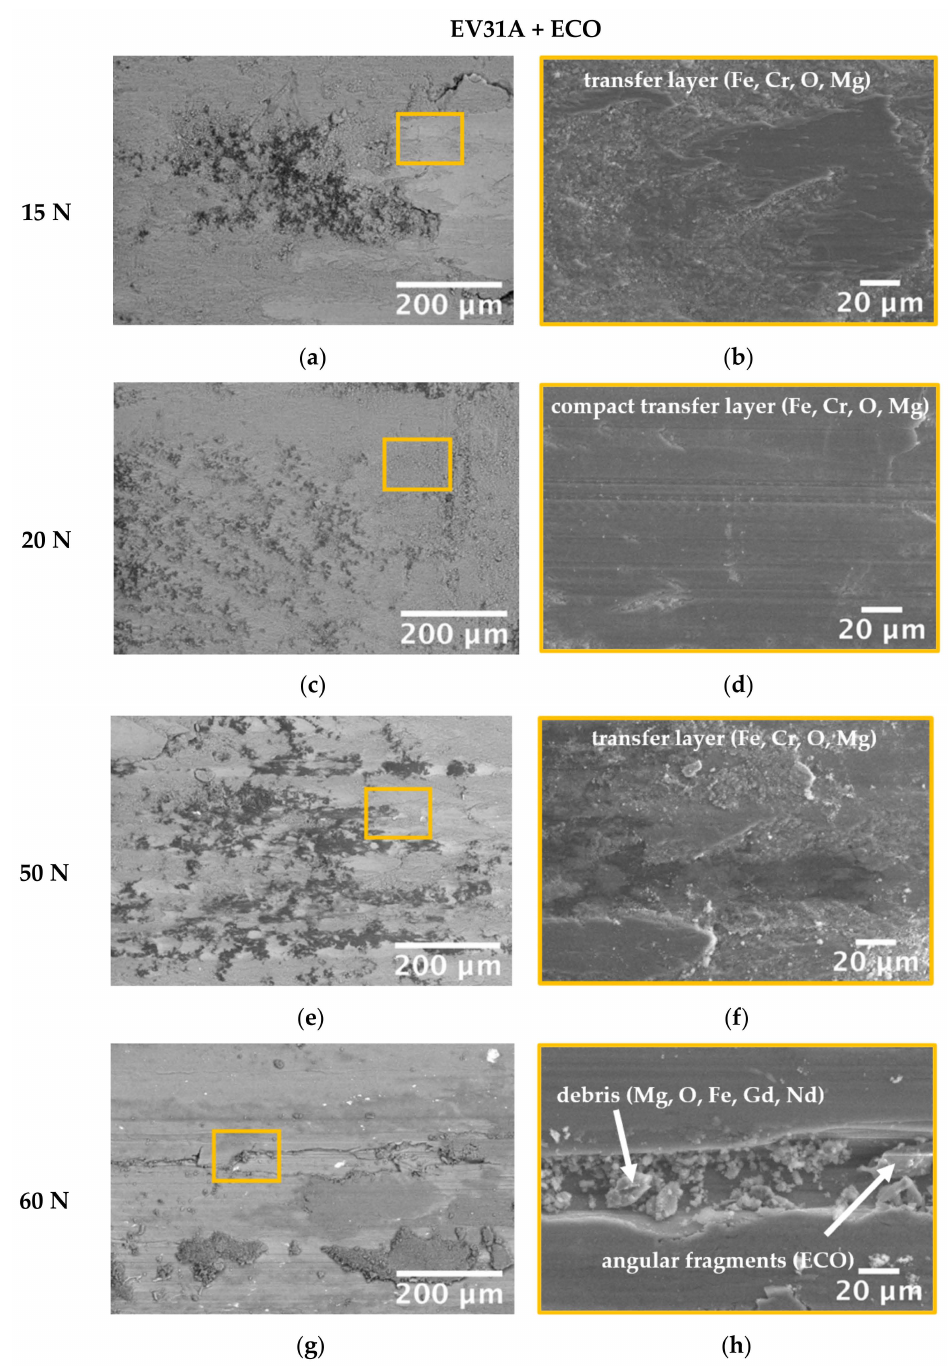
Figure 11. Dry sliding tests (vs. 100Cr6 steel, 1000 m, 0.3 m/s): SEM micrographs of wear scars on ECO-treated sliders at 15 ( a , b ), 20 ( c , d ), 50 ( e , f ) and 60 N ( g , h ): BSE images ( a , c , e , g ) and higher magnification SE details ( b , d , f , h ) in the areas highlighted by the orange frames. The labels indicate the main elements detected by